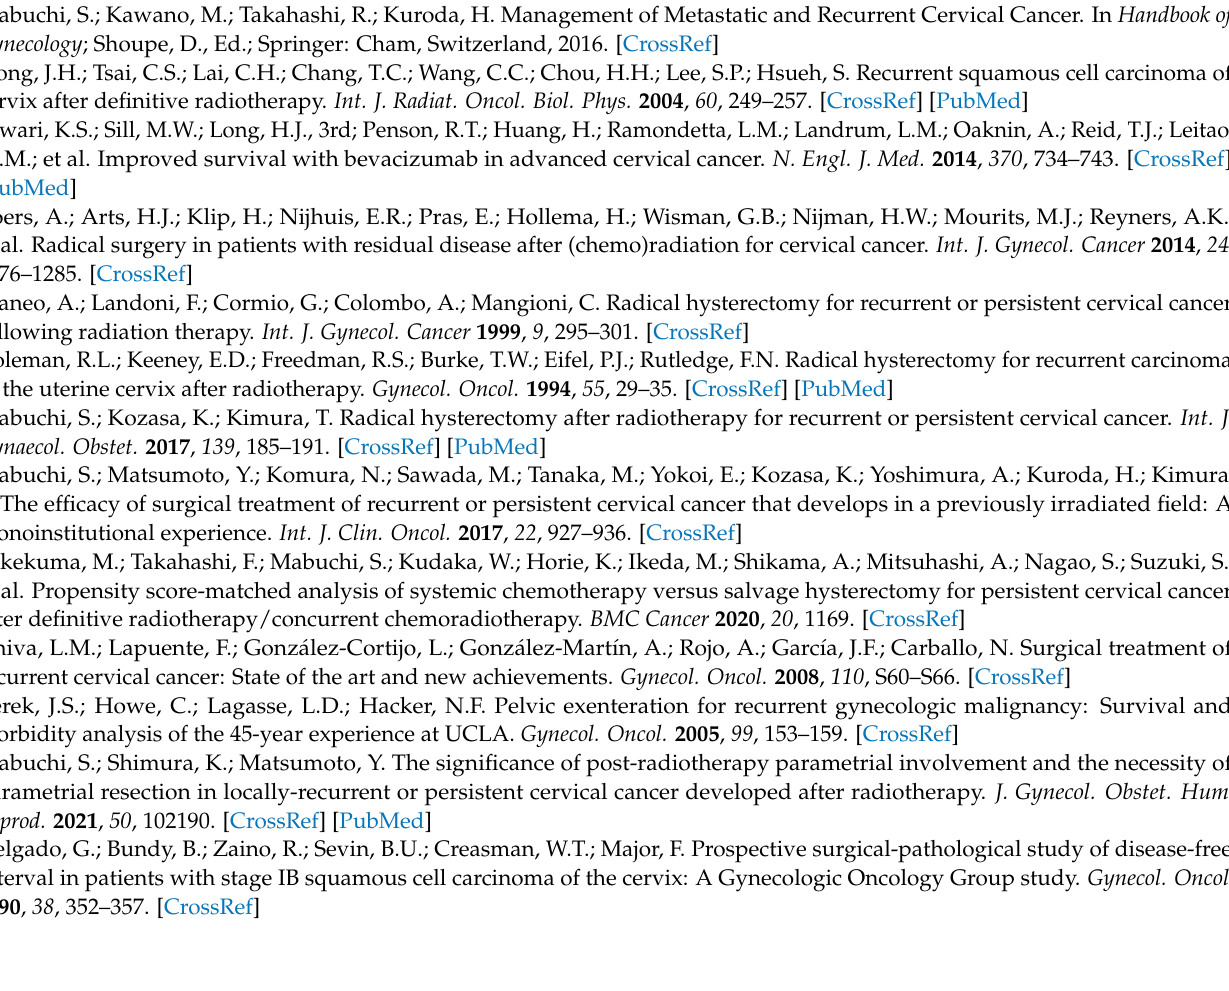
teristics of patients according to lymph node metastasis, Table S2: Surgical outcomes, Table S3: Clinicopathological characteristics of patients according to the number of lymph node metastases, Table S4: Clinicopathological characteristics of patients according to the location of lymph node